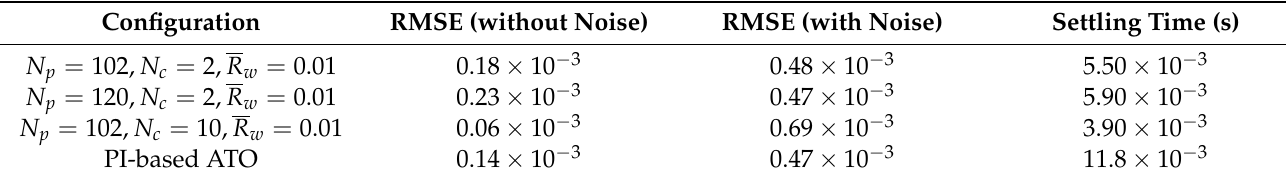
Table 4. RMSE and settling time in the experimental HIL